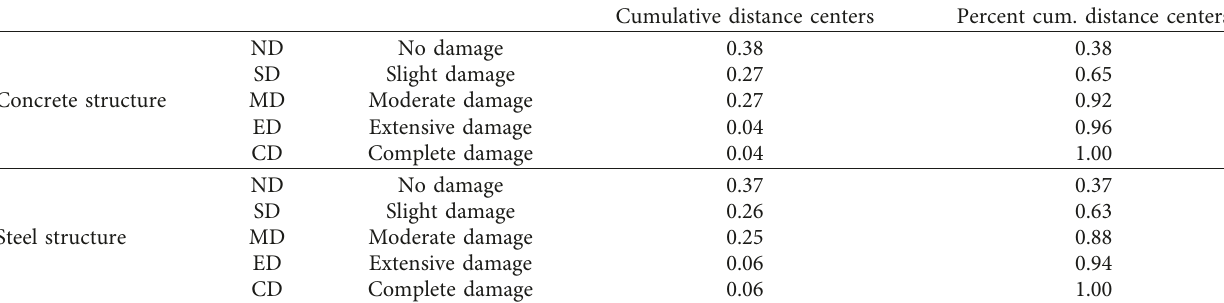
Table 4: Output parameter membership function range. Cumulative distance